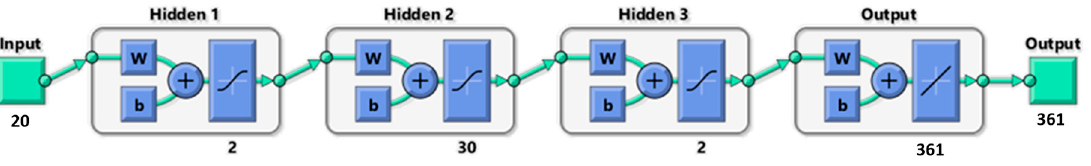
Figure 2. Artificial neural network (ANN) architecture.